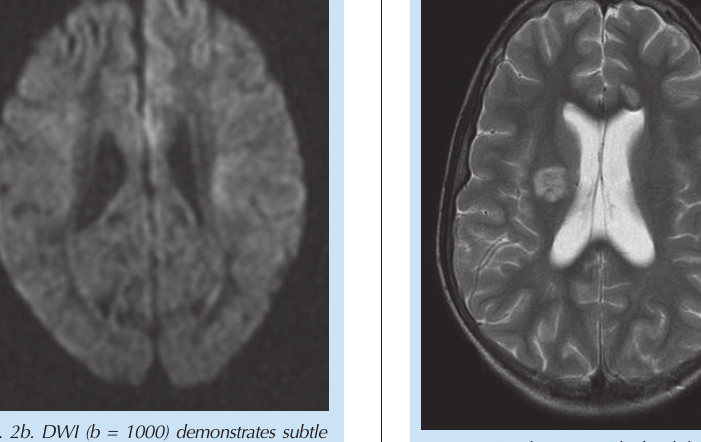
Fig. 4a. Axial T2WI with a well-circumscribed, hyperintense mass lesion in the region of the L quadrigeminal plate cistern.